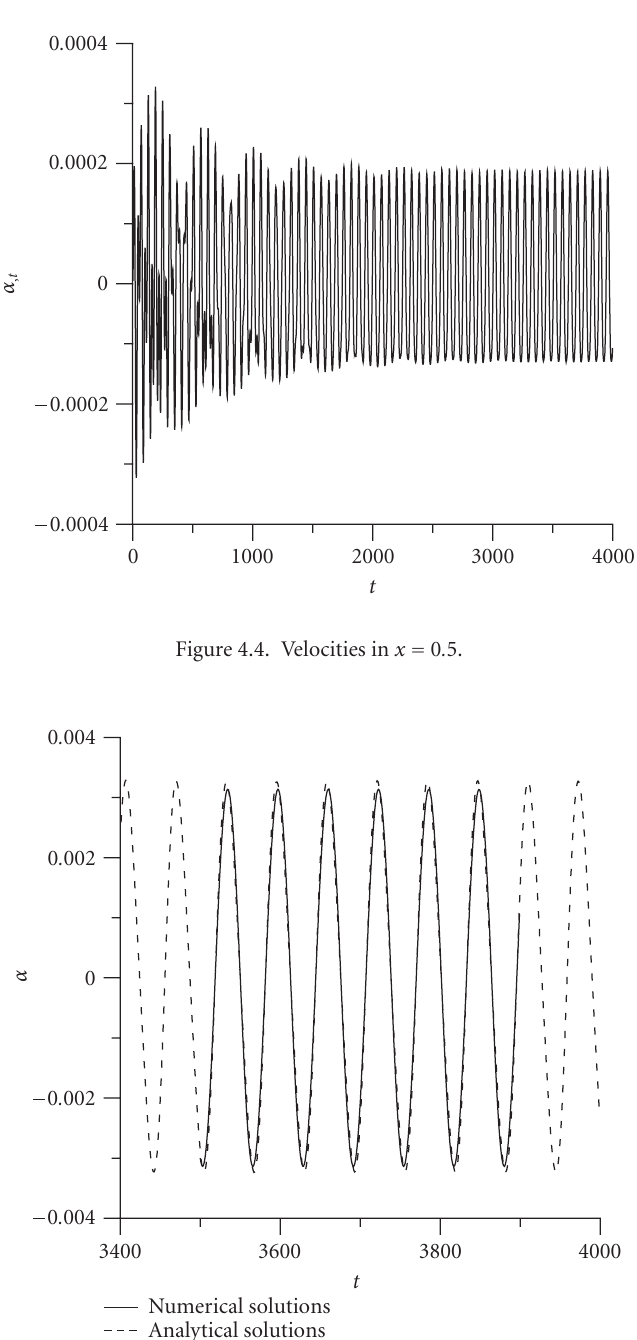
Figure 4.5. Numerical and analytical solutions for displacements in x = 1 in a steady